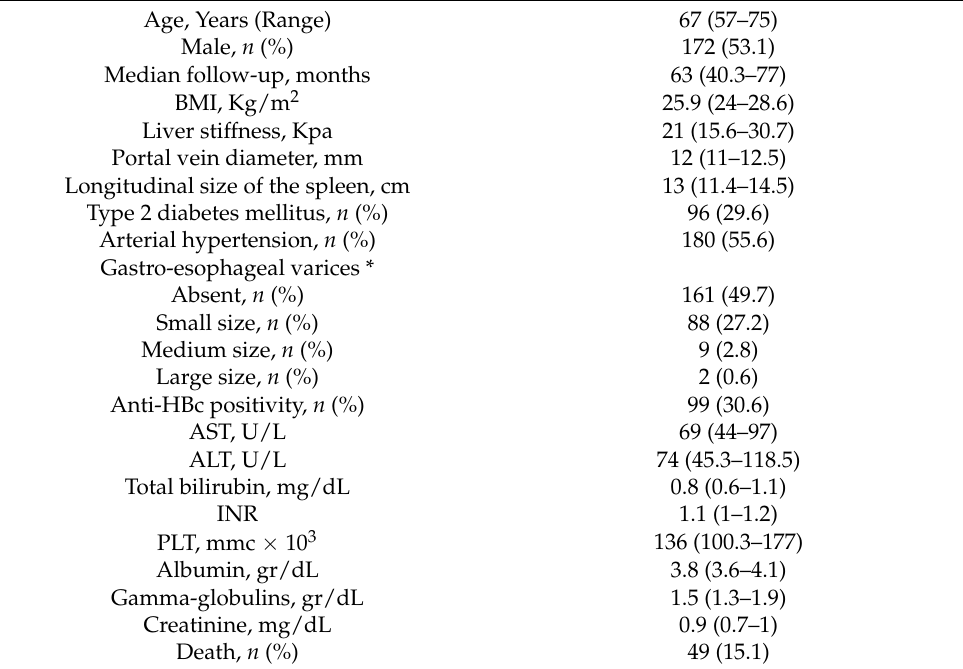
Figure 1. Flow chart of 324 C-P class HCV cirrhotic patients included in the study. Table 1. Baseline demographic, clinical and laboratory characteristics of 324 C-P class A HCV cirrhotic patients included in the study.